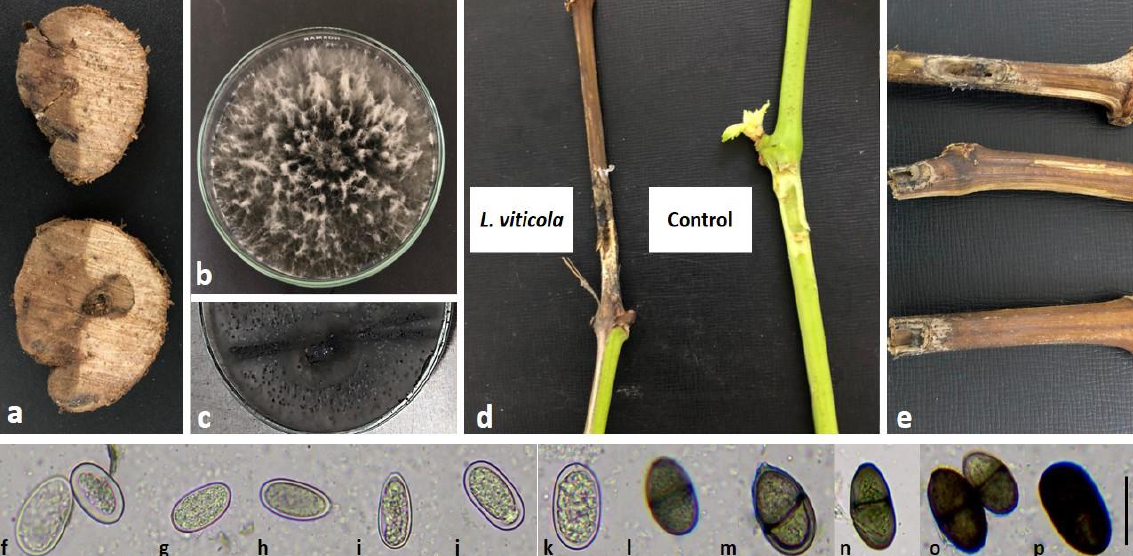
Figure 2. Lasiodiplodia viticola causing Botryosphaeria dieback on the grapevine. ( a ) Characteristic necrosis of Botryosphaeria dieback; ( b ) pure L. viticola culture on a 9 cm diam plate containing